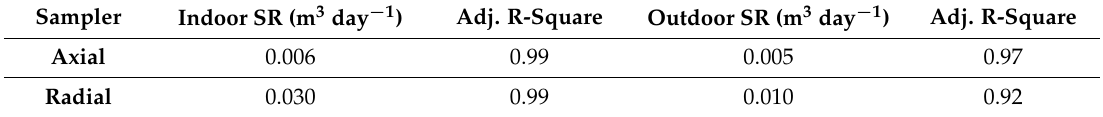
Table 1. Indoor and outdoor SR, with the relative coefficient of determination R 2 .